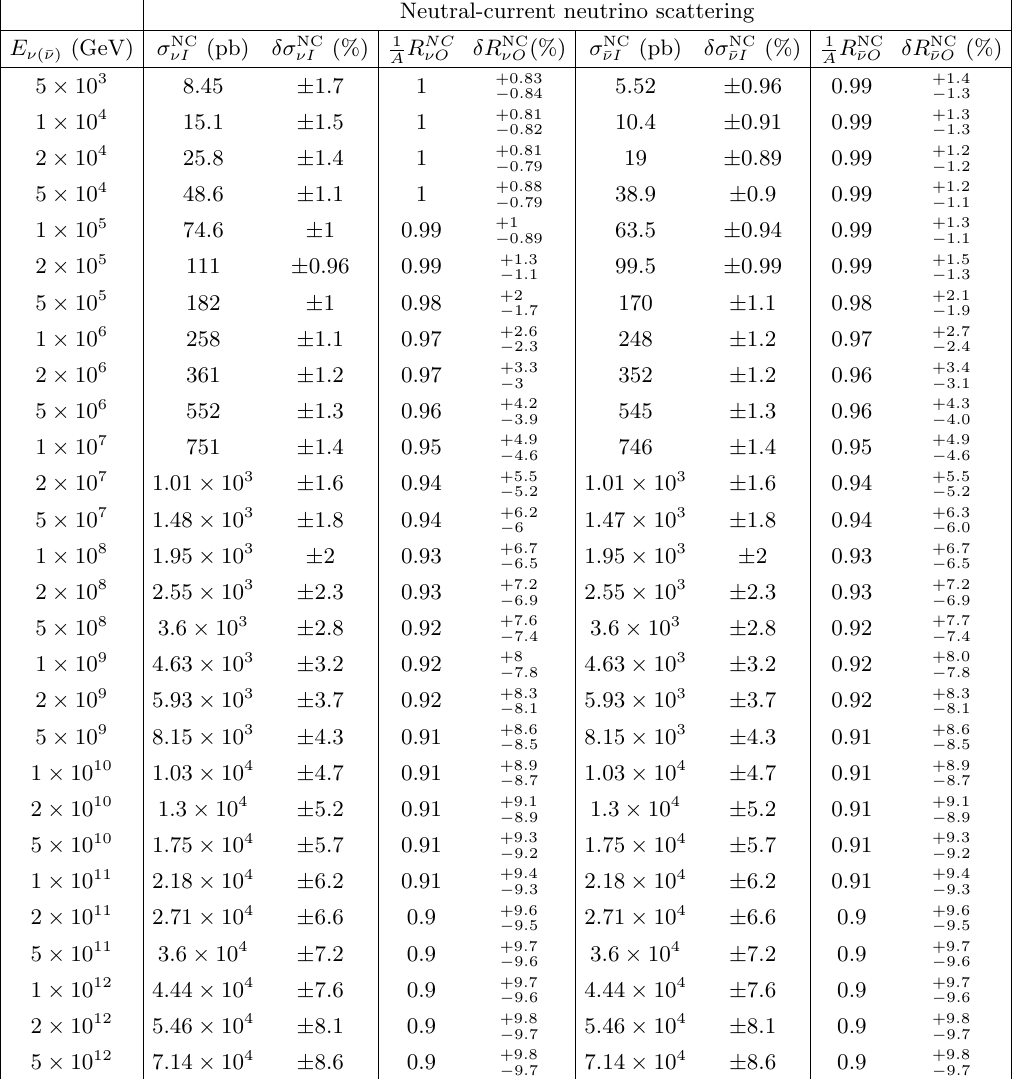
Table 3 . Same as table 2 for the neutral-current scattering cross-sections.